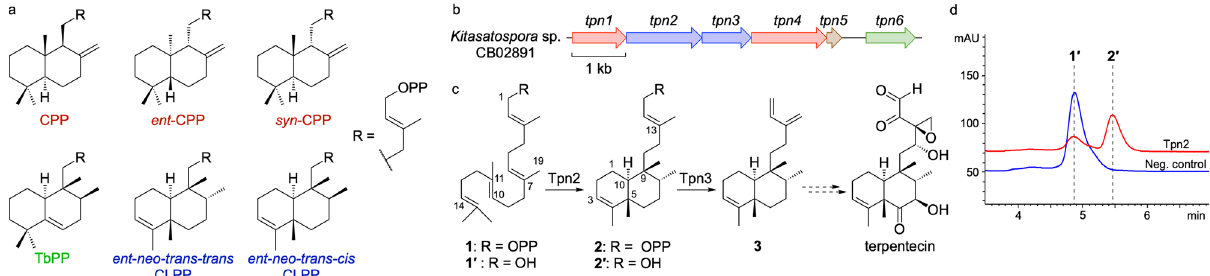
Fig. 1 Proposed biosynthesis of terpentecin. a Structures of labdane (red), halimane (green), and clerodane (blue) skeletons. b The tpn BGC consists of two TSs (blue), two P450s (red), a ferredoxin (brown) and a GGPP synthase (green); mevalonate pathway genes responsible for production of the terpene precursors are found downstream. c Tpn2 fi rst cyclizes GGPP into terpentedienyl diphosphate ( 2 ), a clerodane diterpene. Tpn3 eliminates the diphosphate of 2 to produce terpentetriene ( 3 ). The oxidation of 3 to terpentecin is still unknown. Carbon numbering for both 1 and 2 are shown. d HPLC analysis of the Tpn2 in vitro reaction con fi rms its type II TS activity. Negative control is reaction with boiled Tpn2. Products are shown as the dephosphorylated